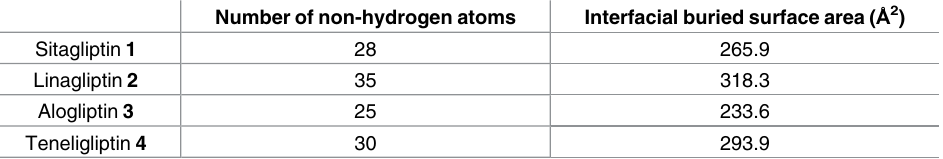
Table 1. Correlation between number of non-hydrogen atoms of ligands and the interfacial buried surfacearea with chain A of DPP-4. The correlation coefficient is